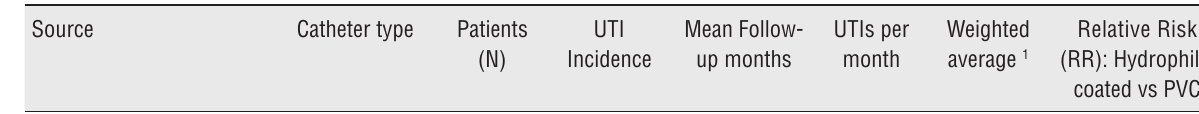
Table 1 - urinary tract infection responding to initial antibiotic